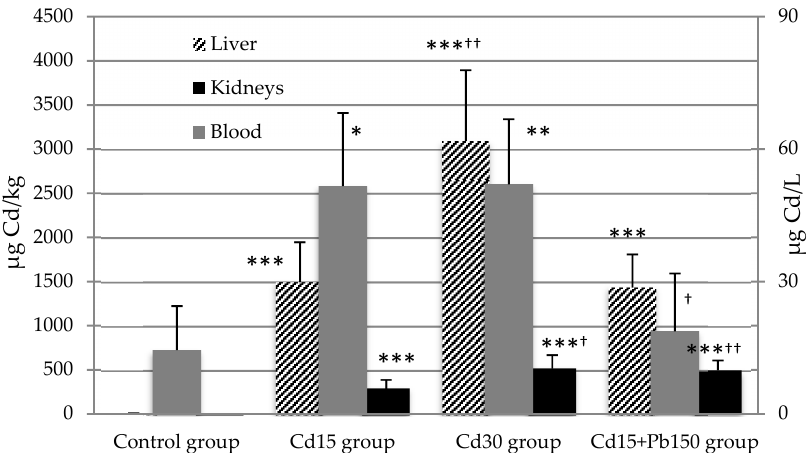
Figure 1. Cadmium concentration in rat blood, liver, and kidneys after acute exposure to Cd and Pb. Cadmium levels in blood are expressed as µg Cd/L and as µg Cd/kg (wet tissues) in liver and kidneys. Values are presented as means and S.D. Statistically significant differences ( p < 0.05) compared to control group are indicated by *, † Cd 15 group. Statistical evaluation was performed using one-way ANOVA followed by LSD post-hoc test for pairwise comparison. * † p < 0.05; ** †† p < 0.01; *** ††† p < 0.001.